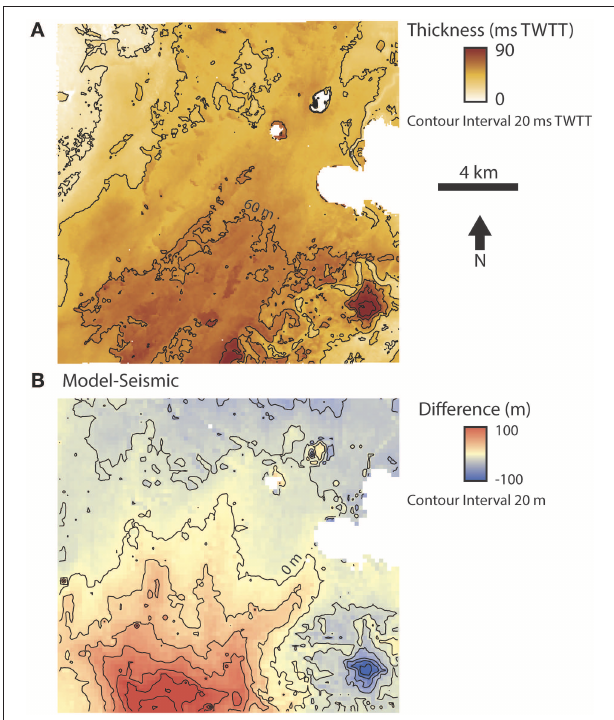
FIGURE 2 | (A) Isochron map of the slope fan from Moscardelli et al. (2006) and Moscardelli and Wood (2008). (B) Difference in thickness between the model and the slope fan in block 25A, offshore Trinidad (modified from Hawie et al.,